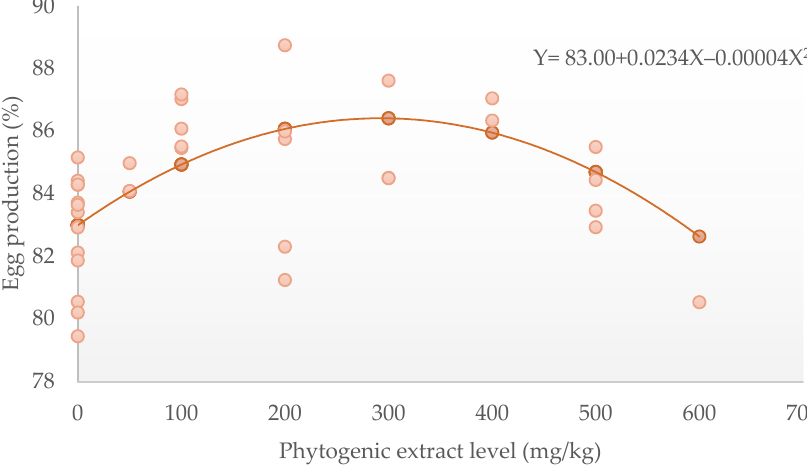
Figure 2. Quadratic equation of dietary phytogenic extract (mg/kg) to egg production (%). Table 2. Regression equations for the impact of phytogenic extract levels on productive perfor- mances of laying hens.